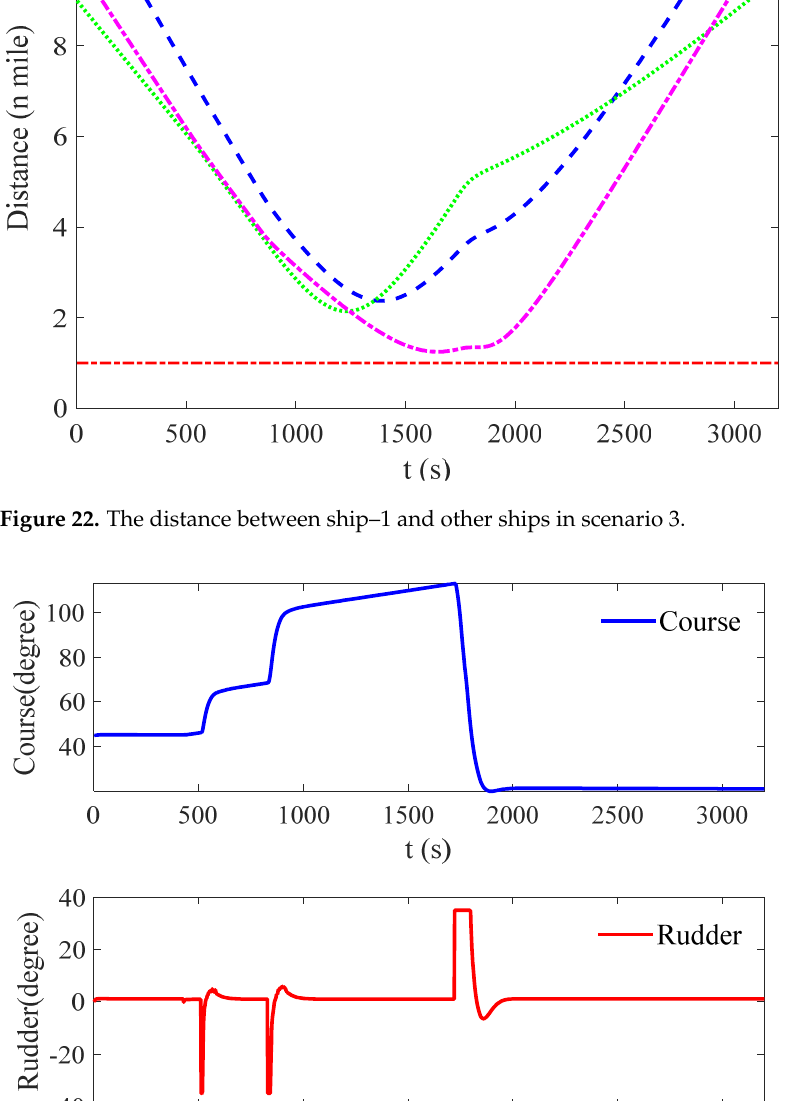
Figure 23. The course and rudder angle of ship–1 in scenario 3.